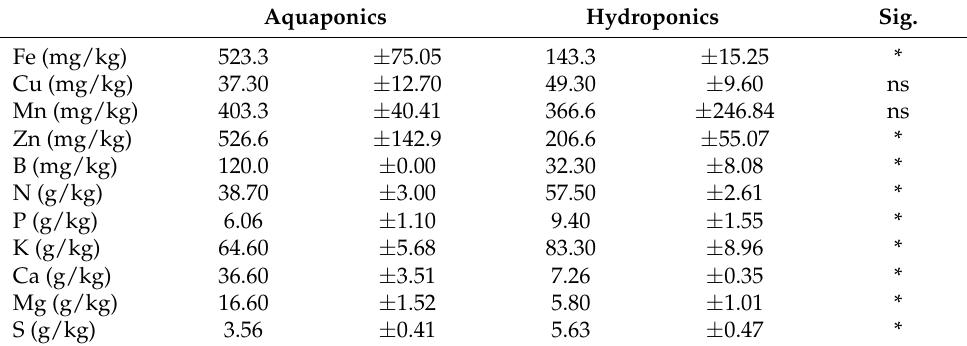
Table 3. Micronutrients (mg/kg) Fe, Cu, Mn, Zn, B and macronutrients (g/kg) N, P, K, Ca, Mg, S in spinach ( Spinacia oleracea ) shoots grown in hydroponic and aquaponic system for 42 days. For aquaponics treatment spinach was grown in a coupled aquaponics system together with rainbow trout ( Oncorhynchus mykiss ).